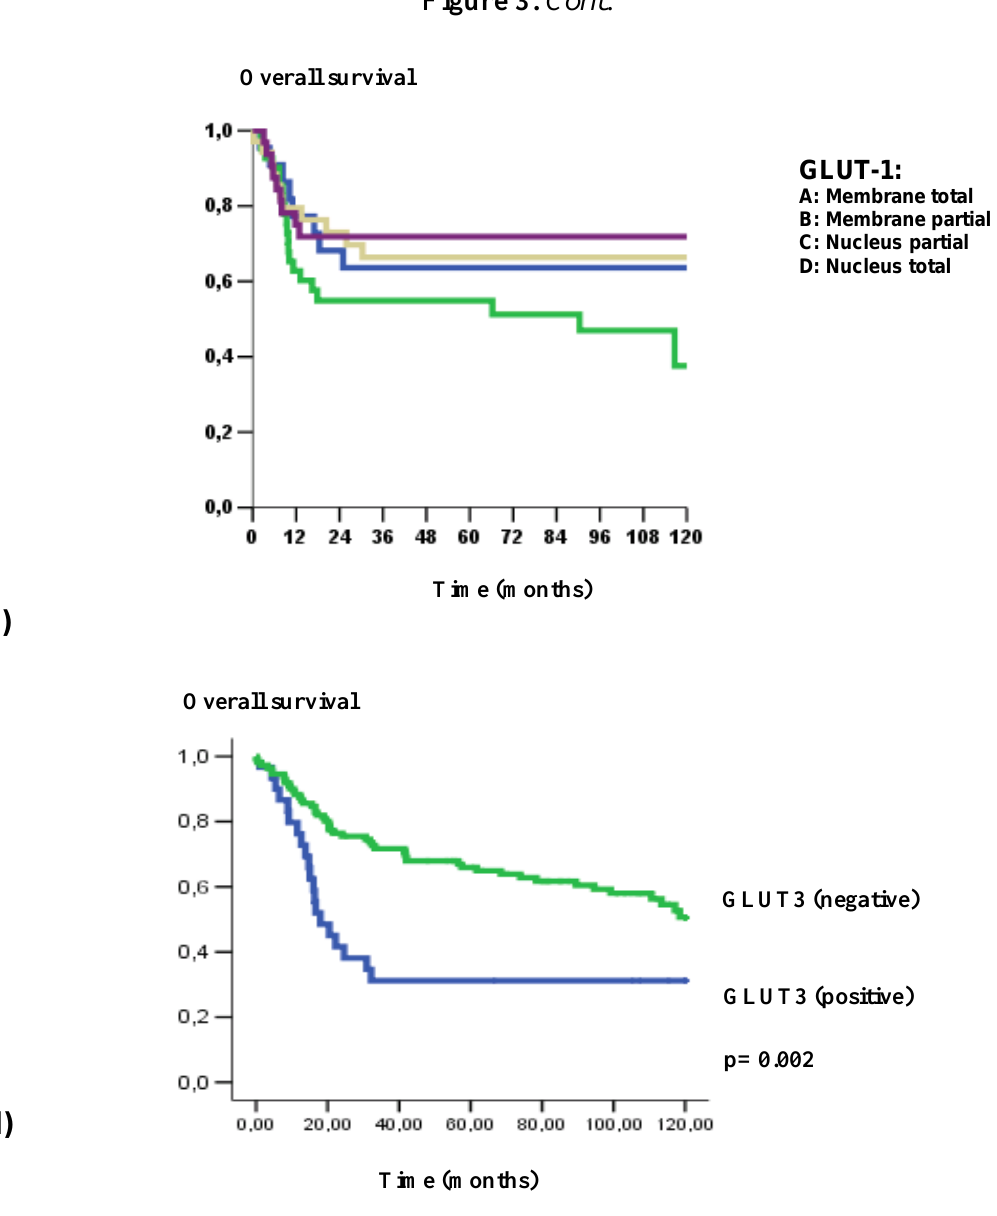
Figure 4. Kaplan–Meier curve of recurrence-free survival in 5 year in OSCC